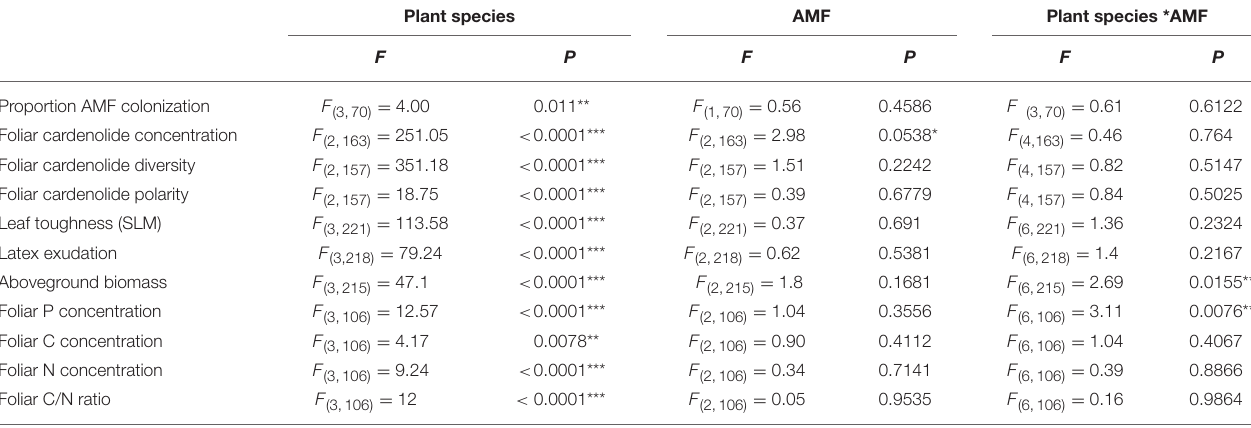
TABLE 1 | Effects of plant species, arbuscular mycorrhizal fungi (AMF) inoculum availability, and their interaction on plant traits, including the proportion of roots colonized by AMF, natural log-transformed foliar cardenolide concentrations, foliar cardenolide diversity, foliar cardenolide polarity, leaf toughness (specific leaf mass, SLM; mg/cm 2 ), natural log-transformed latex exudation (mg), aboveground biomass (mg), foliar P concentration (%), foliar C concentration (%), foliar N concentration (%), foliar C/N ratio.